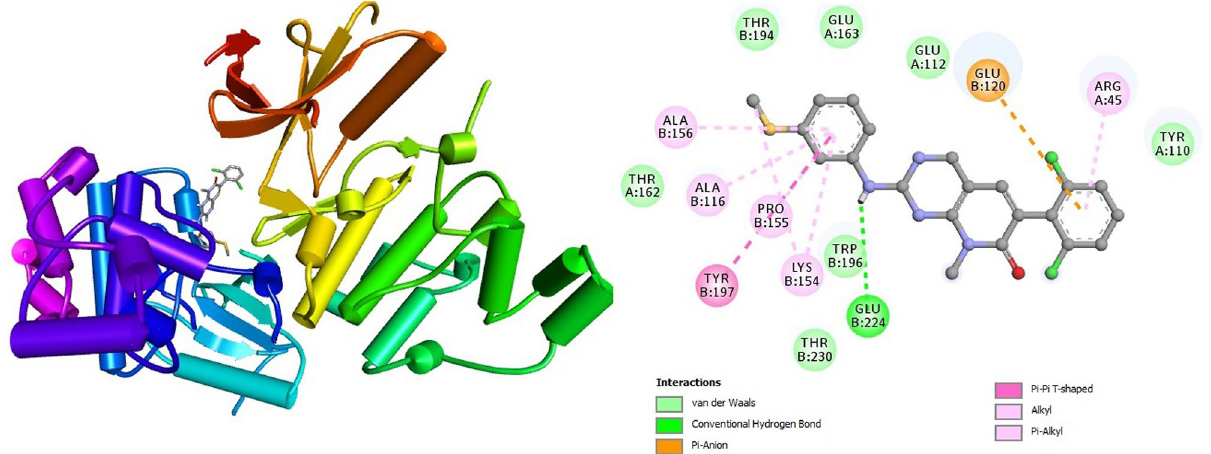
Figure 8. Depicted the interaction between the standard MAPK6 inhibitor (CID: 447077) drug and MAPK6. Left side representing 3D and the right side representing 2D complex protein–ligand interaction.